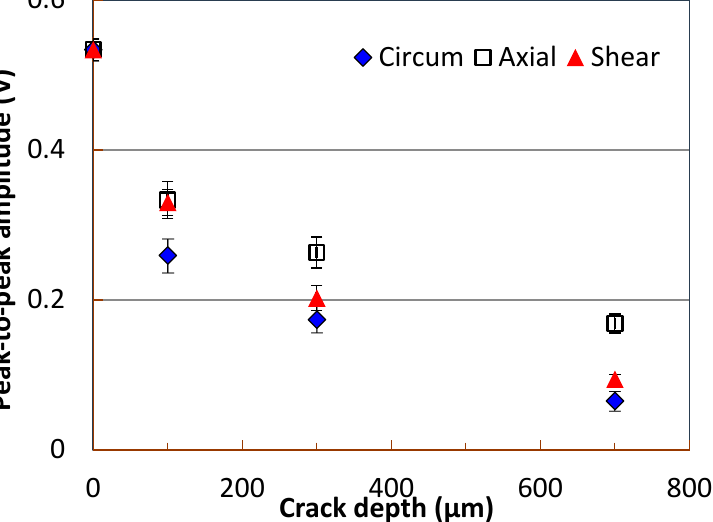
Figure 14. Experiment profiles of peak-to-peak amplitude for defect types at a distance of 6.5 mm from the crack location.